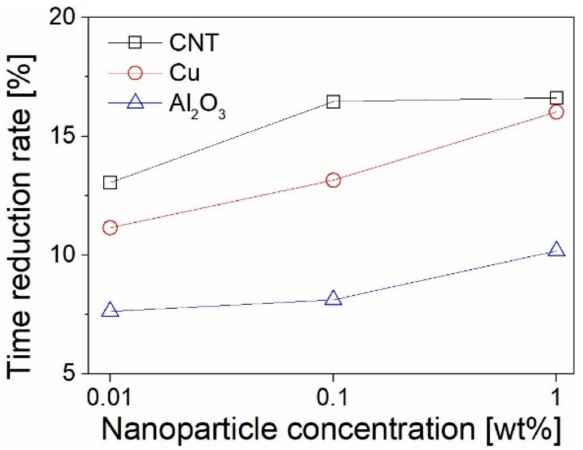
Figure 8. Time reduction rate to reach 50 ◦ C of nanofluids with three different nanoparticle